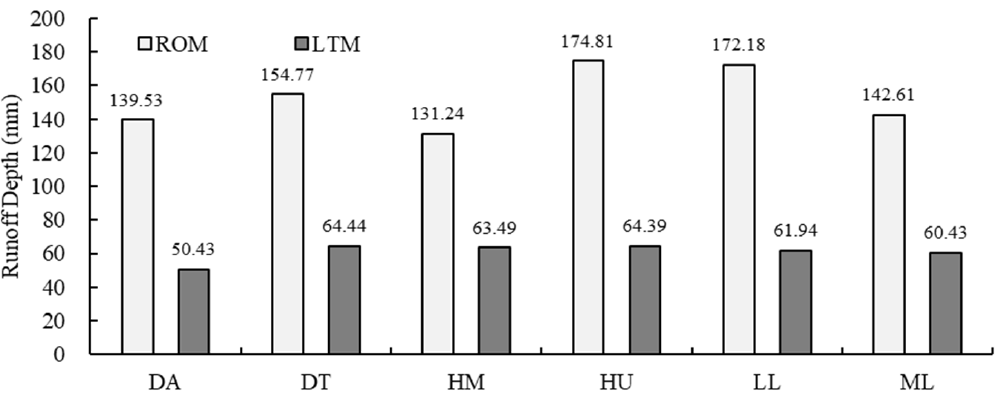
Figure 7. Comparison of average runoff depth in different sub-watersheds.